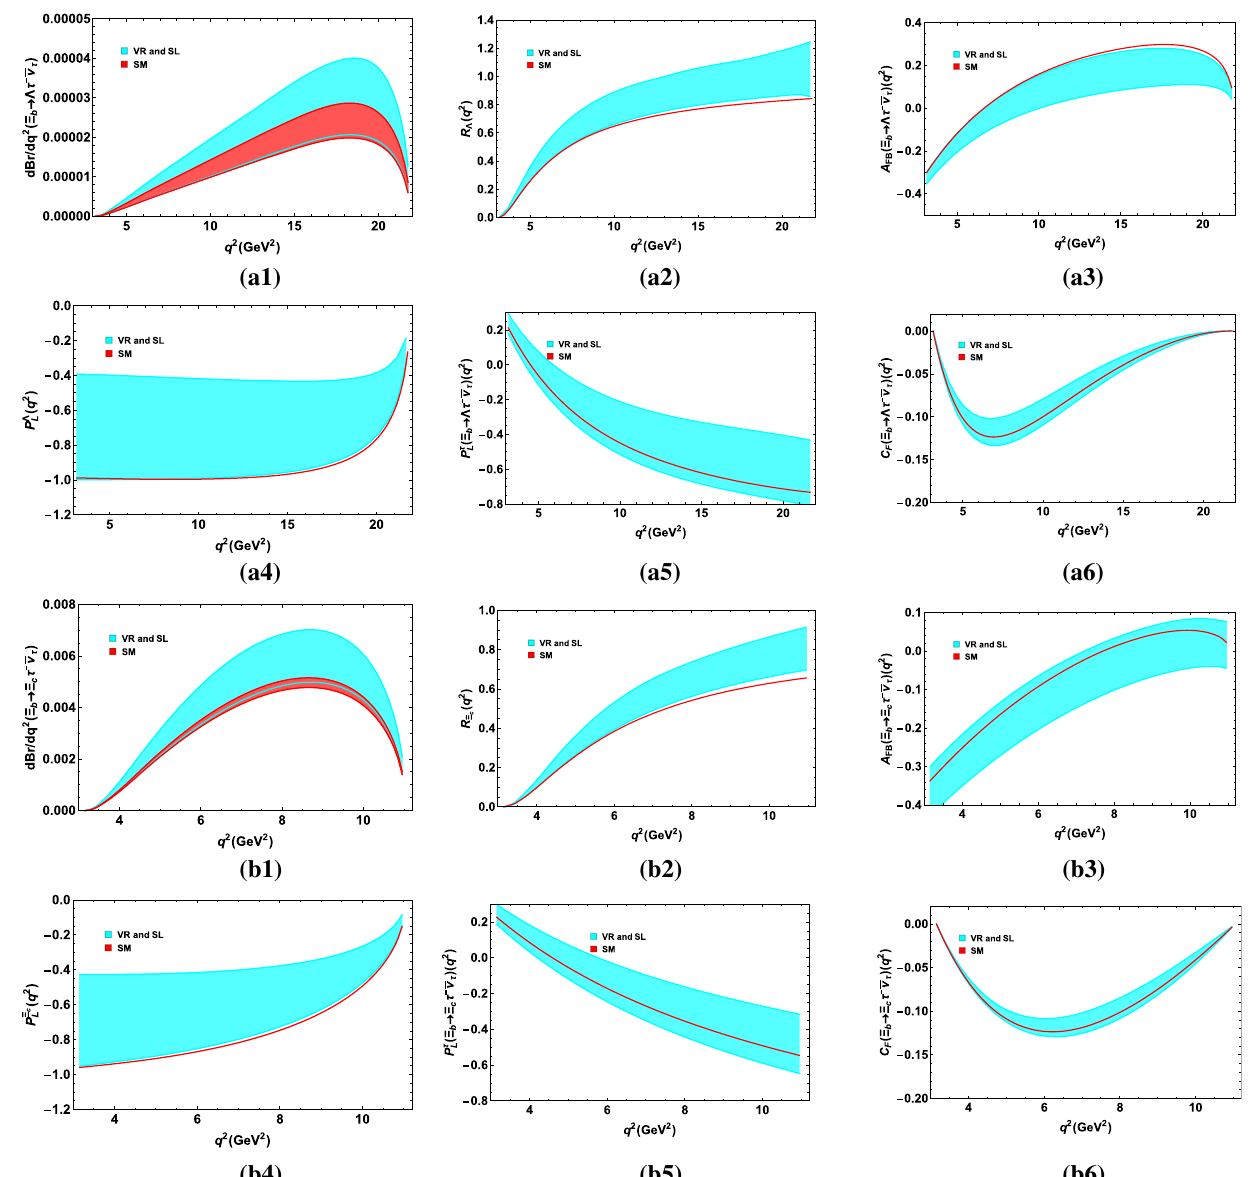
( q 2 ) ( a5 , b5 ) and C l ( q 2 ) ( a6 , b6 ) relative to the decays ( a4 , b4 ), P τ L F (cid:2) → (cid:3)τ − ¯ ν τ and (cid:2) → (cid:2) τ − ¯ ν τ , respectively. The bands contain the b b c (cid:3)((cid:2) c ) ( q 2 ) theoretical uncertainty of the CKM matrix elements | V u ( c ) b L